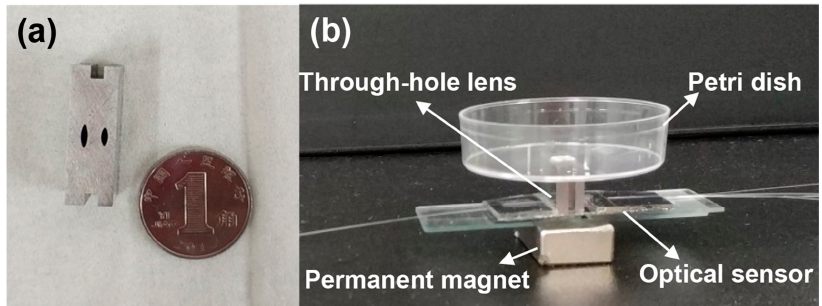
Figure 9. ( a ) Photograph of the container for the cell solution and a Chinese dime; ( b ) Photograph of the cell loading component.